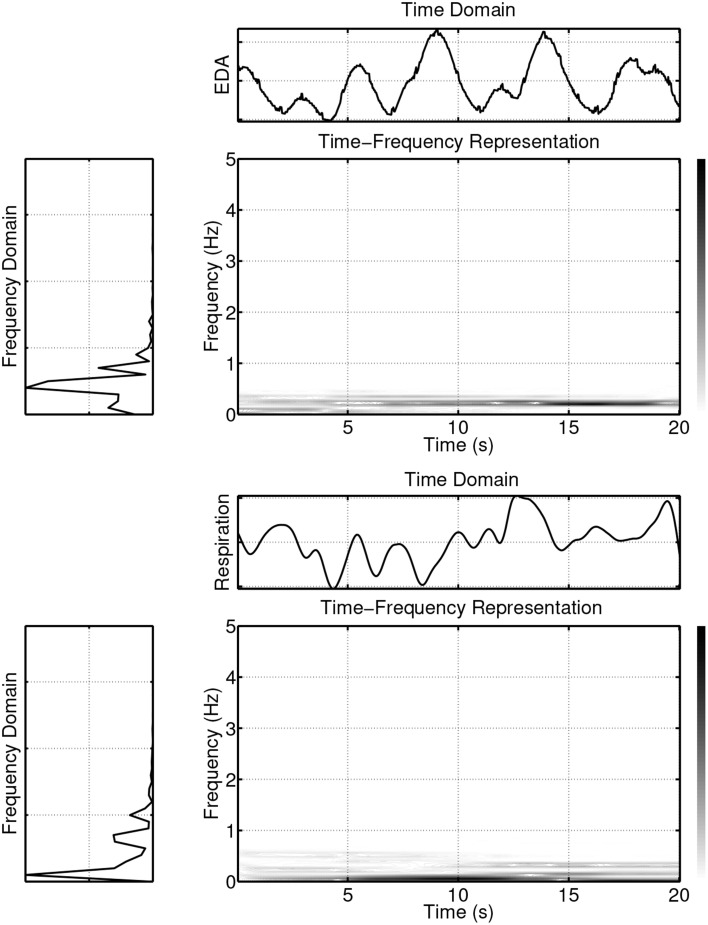
Example of synchronously measured EDA and respiration signals that both contain a cyclic component at the frequency region of approx. 0.4 Hz.